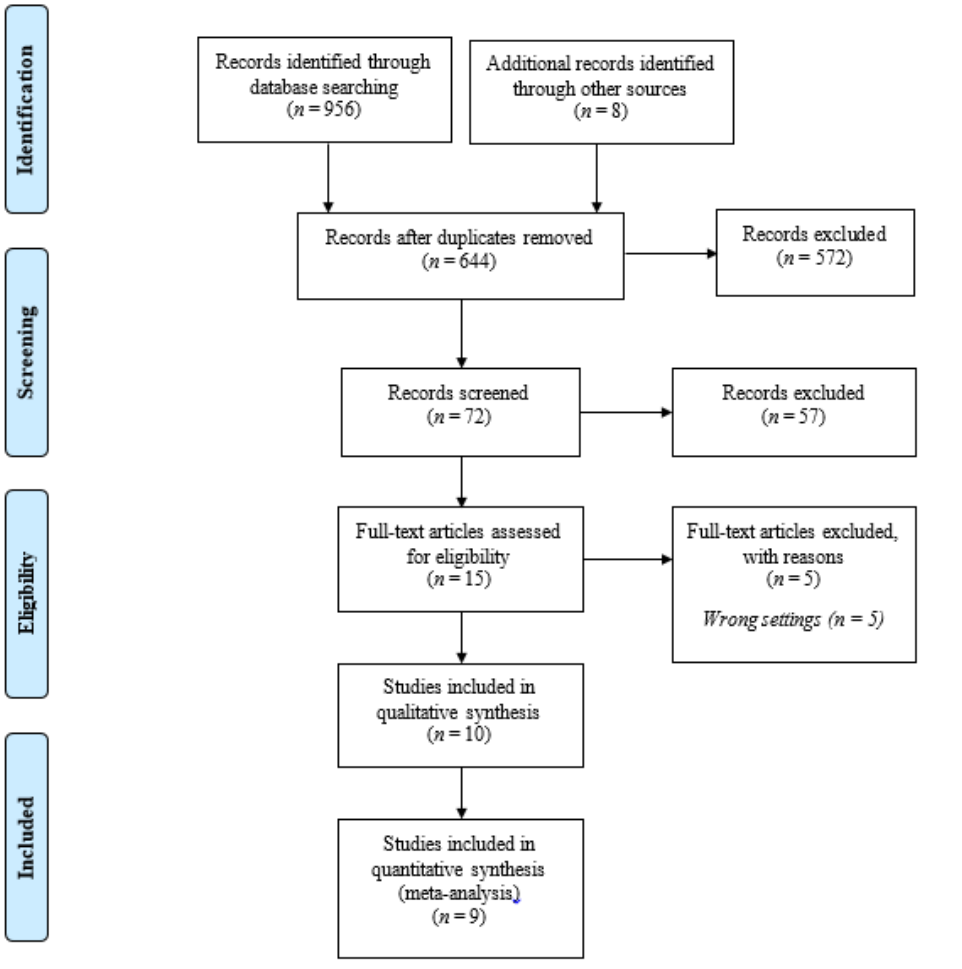
Figure 1. Study selection according to PRISMA guideline .